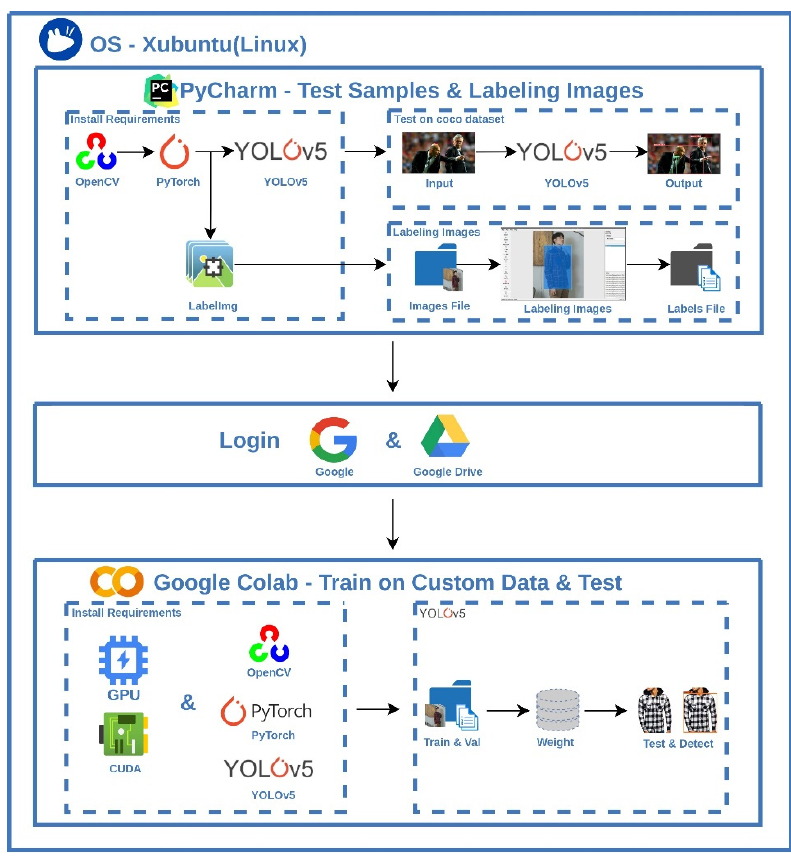
Figure 6. The scheme of the proposed YOLOv5s deep learning environment.